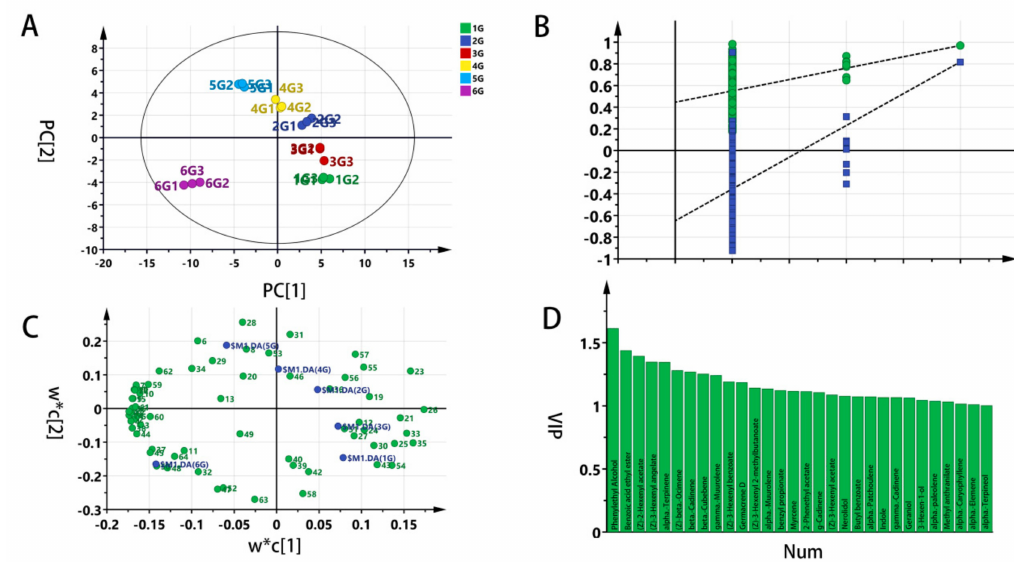
Figure 2. Partial least square-discriminant analysis (PLS-DA) of jasmine tea samples with soft independent modelling by class analogy (SIMCA). ( A ) PLS-DA scores scatter plot with pareto scaling mode (R 2 Y = 0.966 and Q 2 = 0.979); ( B ) The result of the cross-validation model with 200 times of calculations using a permutation test (R 2 = 0.437, Q 2 = –0.661); ( C ) PLS-DA loading scatter